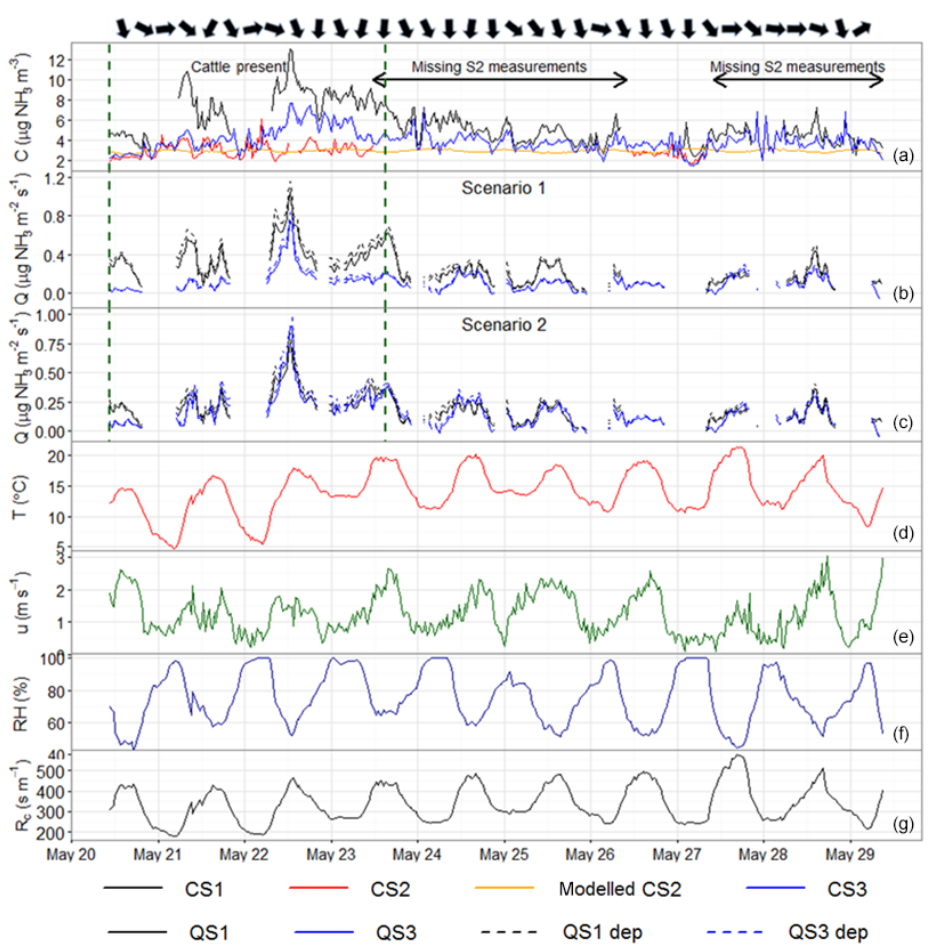
Figure 6. Time series of Period 2 DOAS concentration measurements (a) and bLS-R emission estimates ( b, c ; showing the Q , solid lines, and Q dep , dashed lines, scenarios), with T , u , RH, and R c (with 130sm − 1 offset) shown in the panels below. Panel (b) shows the Scenario 1 (homogenous field) emission estimates, while panel (c) contains the optimised Scenario 2 estimates using the heterogeneous source area coefficients given in Table 1. Periods with missing S2 background concentration measurements are annotated on panel (a) to highlight the higher uncertainty of these periods for emission estimates. Wind direction arrows are set above panel (a) to visualise changes over time. The dashed green lines on the panels (a–c) mark the 3-day time period where the cattle were grazing the